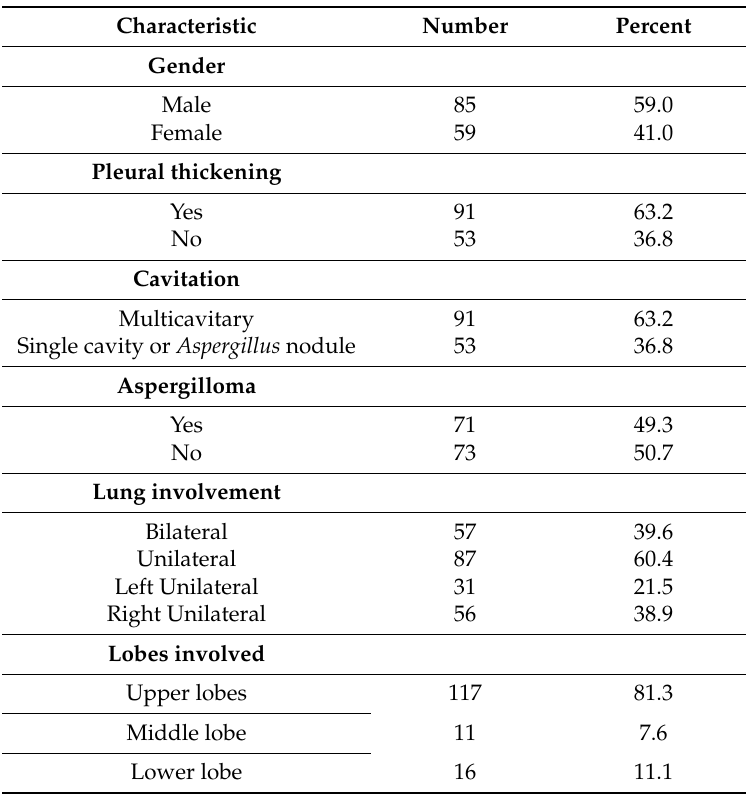
Table 1. Demographic and radiographic characteristics.